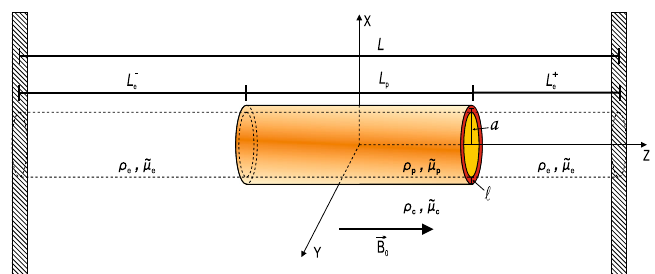
Fig. 79 Model representing a finite length thread. A partially filled magnetic flux tube, with length L and radius a , is considered. The tube ends are fixed by two rigid walls representing the solar photosphere. The tube is composed of a dense region of length L p surrounded by two much less dense zones corresponding to the evacuated parts of the tube. In the prominence region a transversely inhomogeneous layer of length l is considered. The plasma in the prominence region is assumed to be partially ionised with an arbitrary ionisationdegree ˜ μ p .Boththeevacuatedpartandthecoronaaretakentobefullyionised.Imagereproduced with permission from Soler et al. (2010a), copyright by